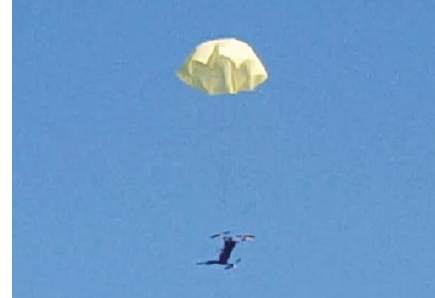
Figure 12: System testing under real